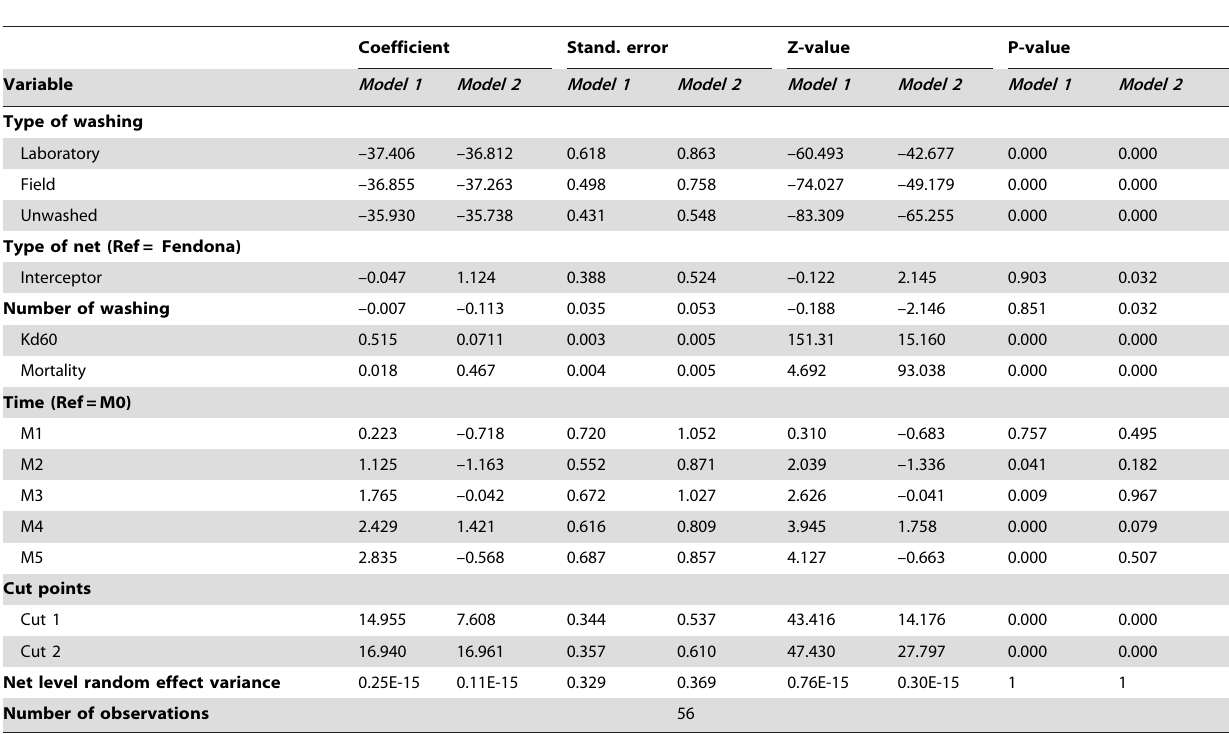
Table 2. Two level proportional odds regression models for the efficacy of LLINs determined from kd60 (model 1) and mortality (model 2)